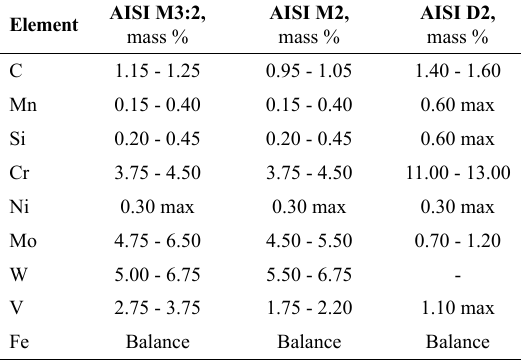
Table 2. Chemical composition of the three powder mixtures carried out along this work in accordance with AISI standards 32 AISI M3:2, Element mass %